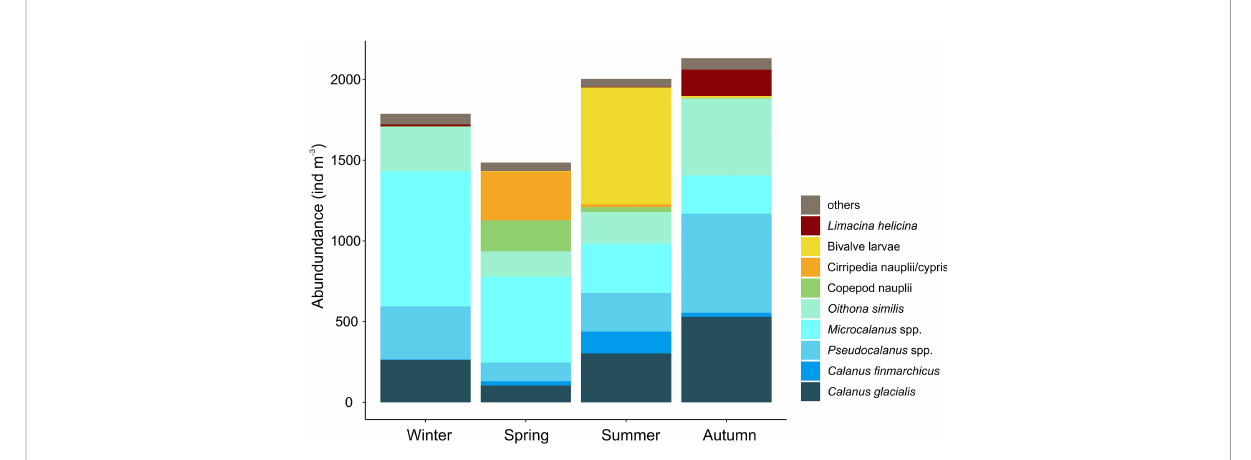
FIGURE 5 Average integrated abundance of the most dominant zooplankton species (ind. m − 3 ) in Billefjorden (2011 – 2013) in the four seasons identi fi ed by multidimensional scaling (see Figure 4): Winter (December – April), Spring (May – June), Summer (July), and Autumn (August –